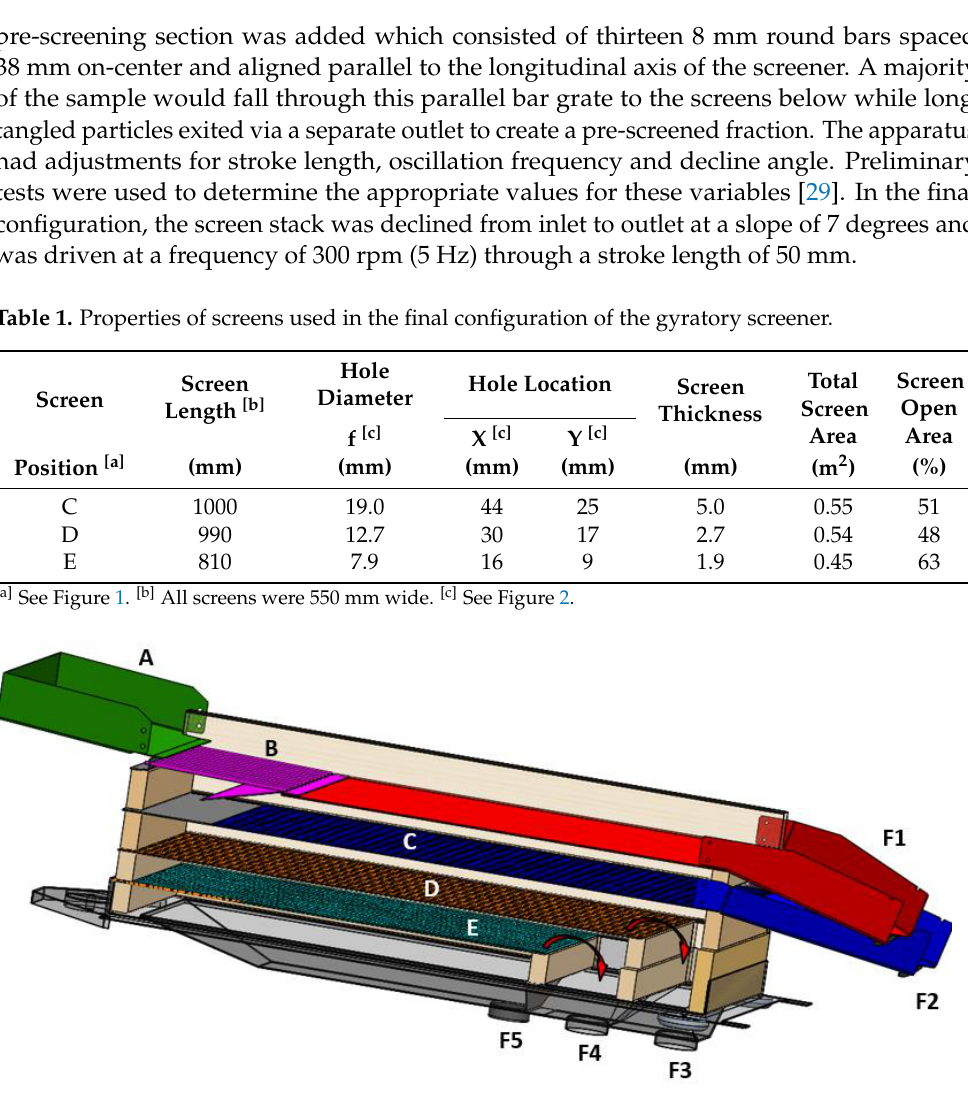
Figure 1. Schematic of gyratory screener showing (A) input pan; (B) pre-screening section; (C) top, (D) middle, and (E) bottom screens. Material passing through pre-screener was fed onto the top screen. Material passing over pre-screener was fraction 1 (F1); material passing over the top, middle or bottom screens were fractions F2, F3 and F4, respectively; and material passing through the bottom screen was fraction F5.